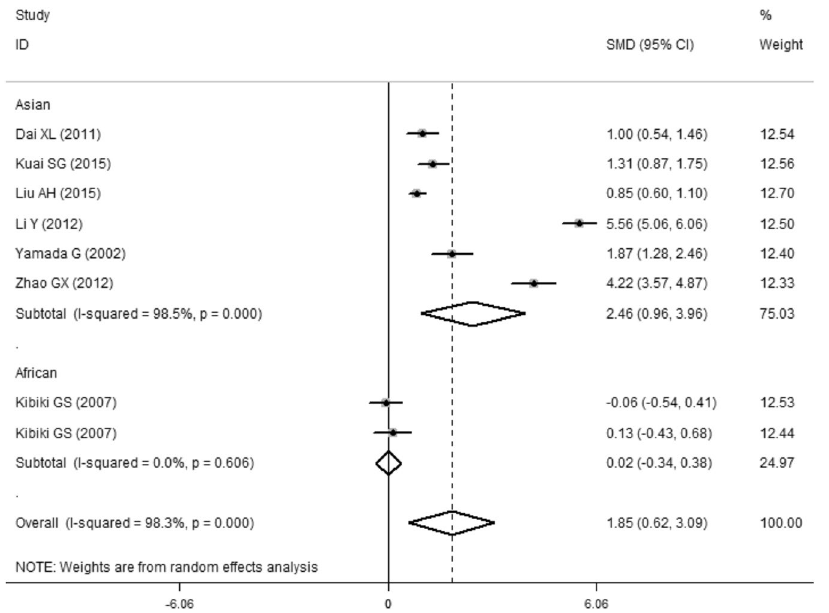
Figure 4. Meta-analysis results of the association between the serum MIF levels and PTB.